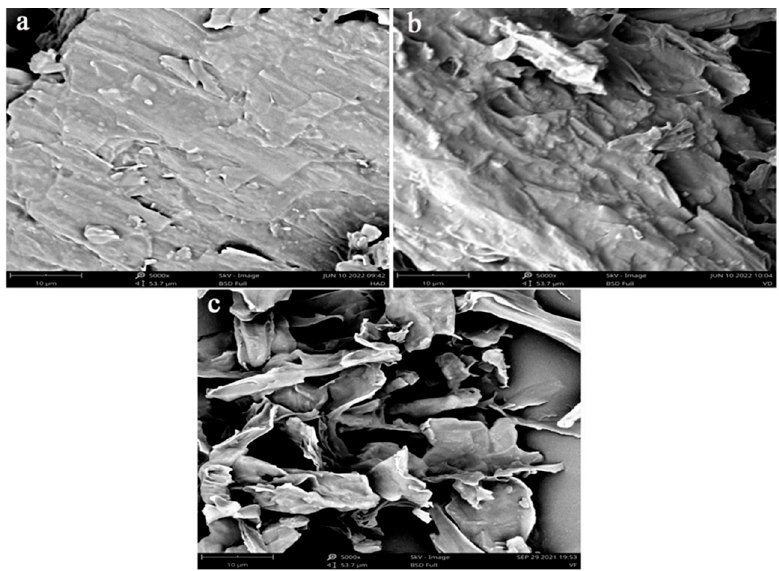
Figure 2. The microstructure of L. decastes under different drying methods: ( a ) hot-air-drying sample; ( b ) hot-air-combined-with-vacuum-drying sample; ( c ) vacuum-freeze-drying sample.